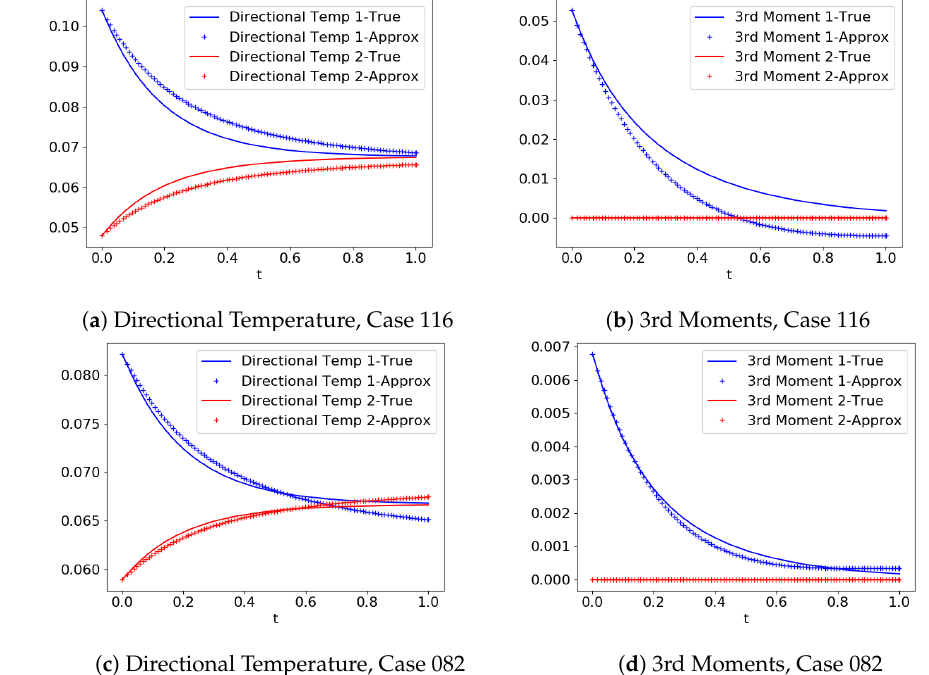
Figure 8. Comparison of moments between numerically computed and machine learning computed solutions. The red and blue curves correspond to different coordinate directions. The case numbers merely serve to differentiate the runs. Time axis is normalized to the maximum time for which training data existed.